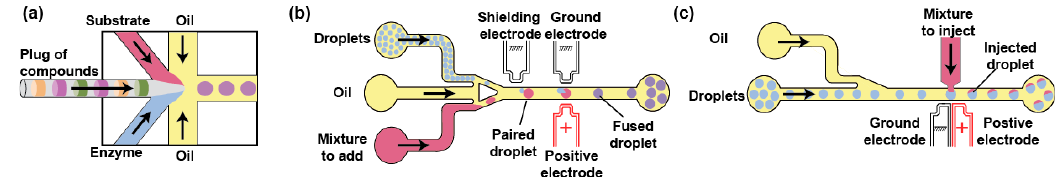
Figure 3. Main strategies for modifying droplet content. ( a ) Modification before droplet production. Plugs of compounds spaced by a carrier liquid (in gray) are injected into a droplet generator and combined with two other aqueous phases (containing enzyme and substrate) just prior to being emulsified. ( b ) Droplet fusion device. Schematic of an active droplet fusion device where droplets are synchronized and fused when passing between a pair of electrodes. Here, small droplets (blue) are reinjected, spaced, and synchronized with larger droplets (red) generated on-chip. ( c ) Droplet picoinjection device. Droplets are reinjected and spaced by an oil stream. When passing in between an orthogonal channel containing the fluid to inject and a pair of electrodes that destabilize droplet/liquid interface, the droplets receive a controlled volume of fluid. Arrows indicate flow directions.